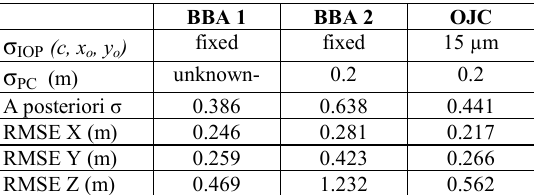
Table 8. Results for aerial images of band 8 with IOPs of band 8 from terrestrial calibration: a posteriori sigma and RMSE in the check points coordinates.